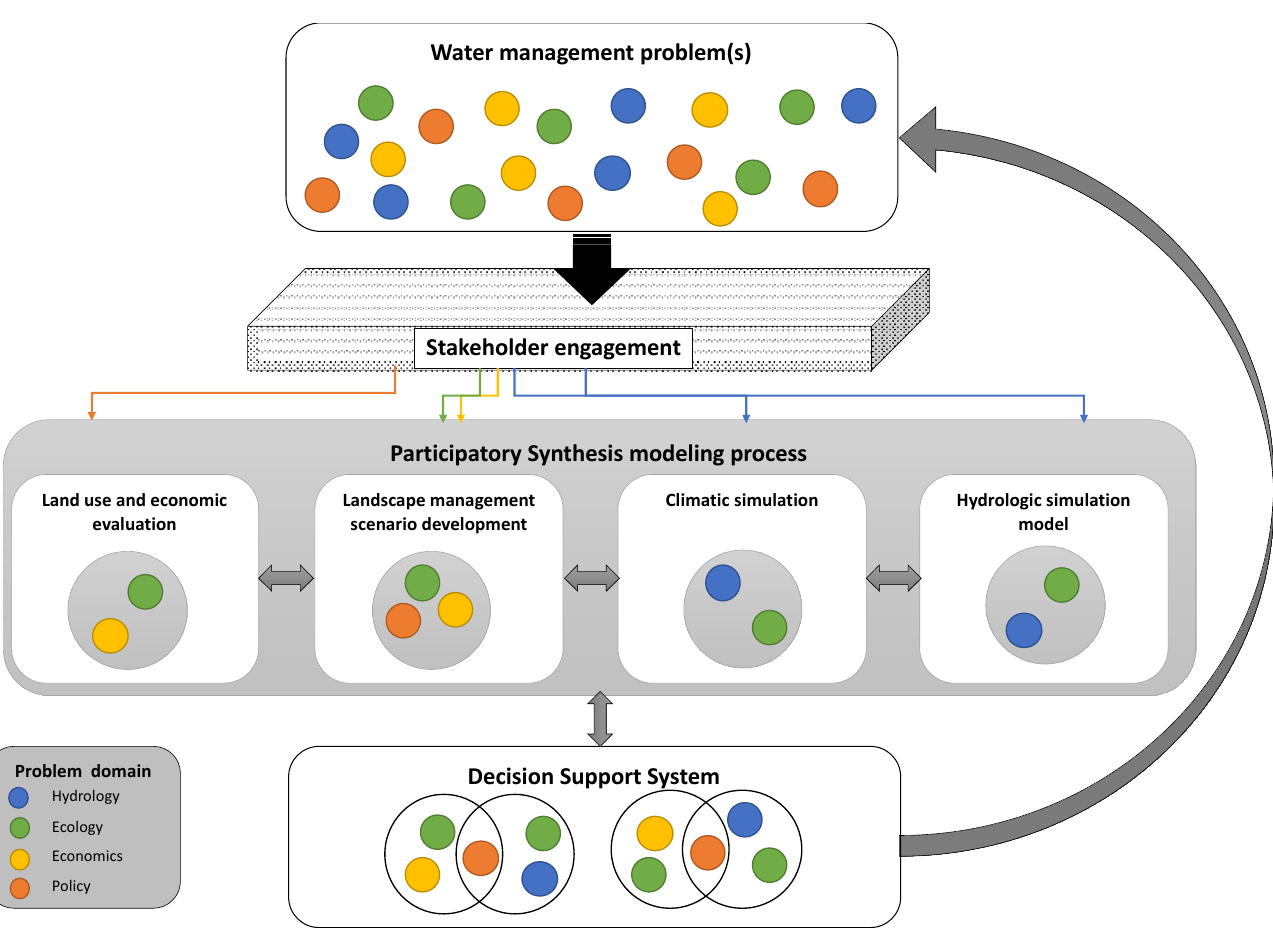
Figure 2. Iterative stakeholder engagement and collaborative modeling process to address complex water resources management challenges.